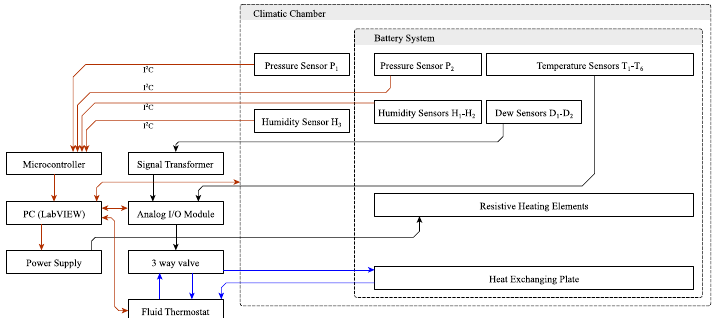
Figure 4. Experimental setup and communication between equipment ( brown line : communication, black line: analog signal, blue line : coolant).